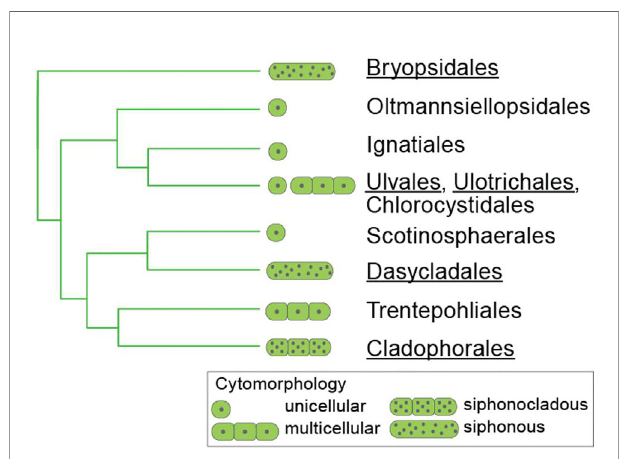
FIGURE 2 | Relationships between the orders of Ulvophyceae, based on Del Cortona et al., 2020 and S ̌ kaloud et al., 2018. Those orders for which information on sulfated polysaccharides is available are